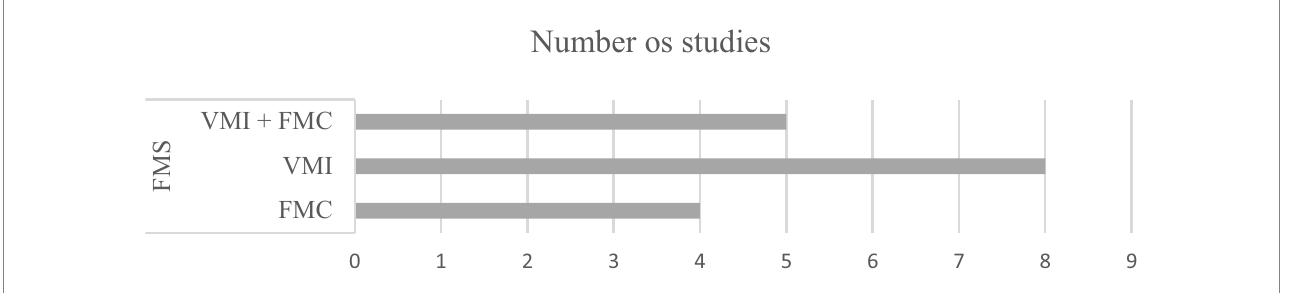
FIGURE 4 Distribution of studies associating FMS, FMC and VMI to math skills. FMC, fine motor coordination; FMS, fine motor skills; VMI + FMC, visuomotor integration plus fine motor